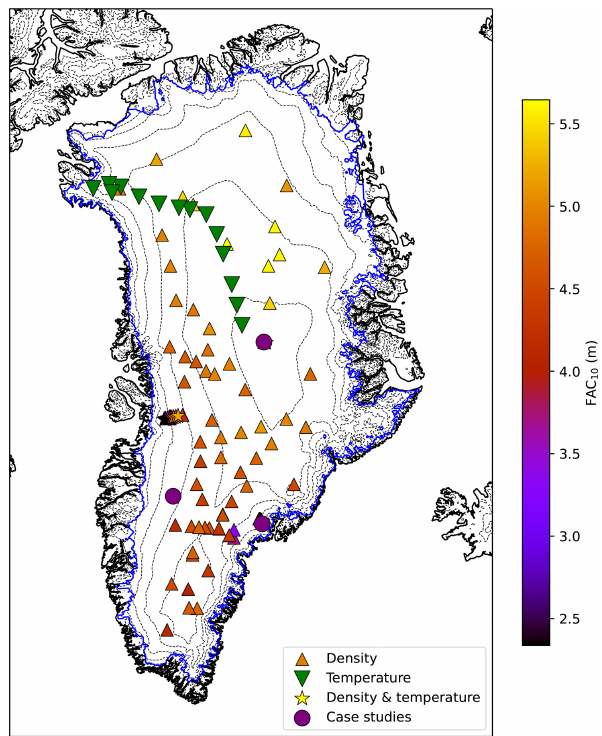
Figure 4. Locations of observed density (upward triangle), 10m temperature (downward triangle) and both (stars). The colour of the upward triangles and stars indicates the measured firn air content for the first 10m of snow at that location (FAC 10 ). The three purple circles indicate the locations of the case studies discussed in Sect. 4. Dashed lines represent 500m elevation contours, the solid blue line the contiguous ice sheet margin. The name of each location is listed in the Supplement.